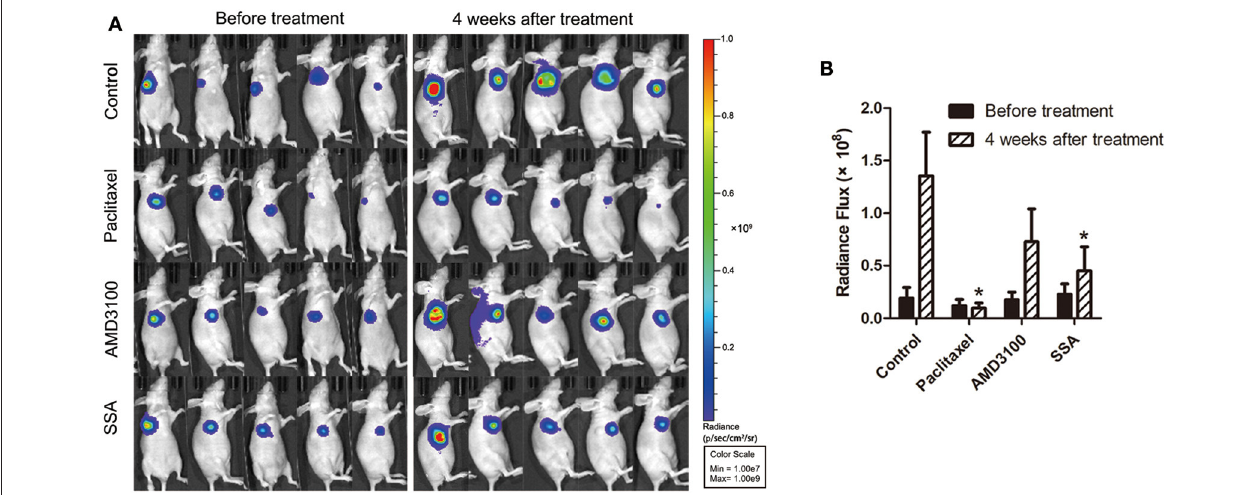
FIGURE 2 | SSA reduces orthotopic tumor growth of MDA-MB-231-luc cells. (A) Luciferase imaging of primary tumors before and 4 weeks after treatment with paclitaxel, AMD3100, or SSA. (B) ROI analysis of images was used to quantify bioluminescence from orthotopic tumors of mice. The data represent mean values ± SEM for photon flux in each group ( n = 5). * p < 0.05, vs.